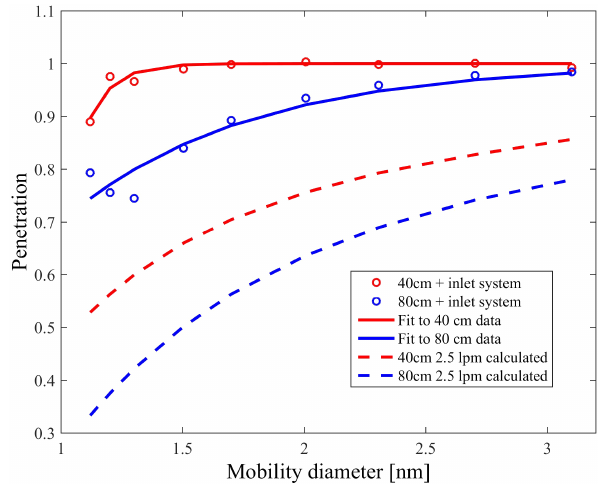
Figure 11. Measured particle penetration efficiency as a function of mobility diameter through the new inlet system (dots) with fitted lines to guide the eye. Dashed lines are calculated penetration effi- ciencies according to the Gormley and Kennedy equation for equal line lengths with 2.5Lmin − 1 flow rate (nCNC inlet flow rate).